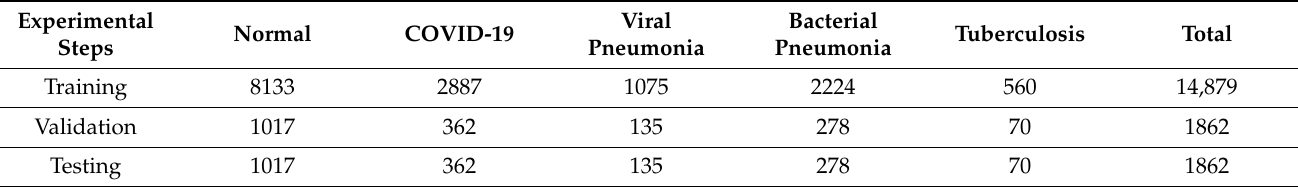
Table 1. Experimental steps and class-wise distribution of chest X-ray